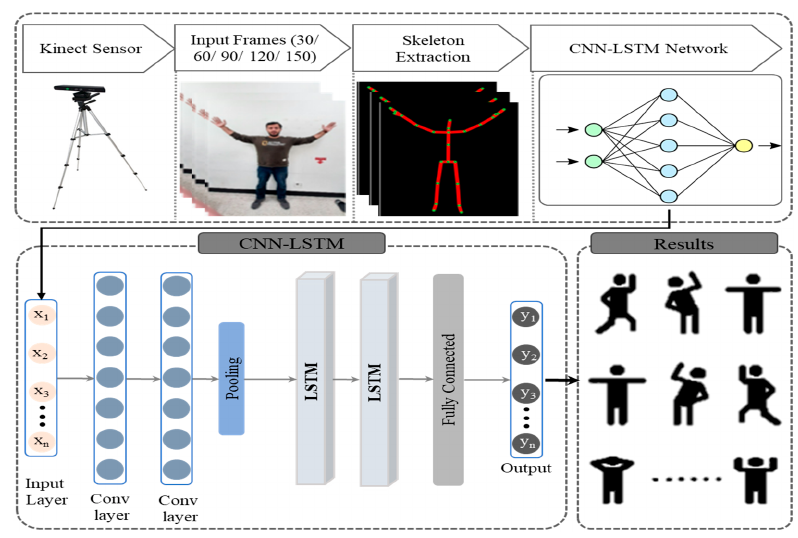
Table 2. Parameters setting of our proposed model.